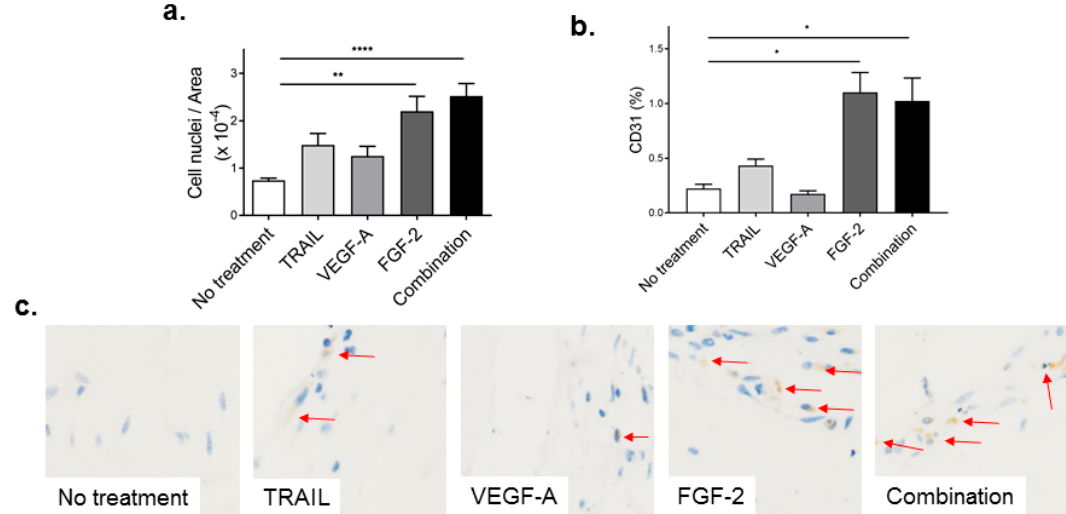
Figure 5. FGF-2 increases cell infiltration and CD31 capillaries in the Matrigel plug. Liquid Matrigel containing TRAIL, VEGF-A or FGF-2 at 400 ng/mL, or a combination of all three at 400 ng/mL each, was injected subcutaneously into the flank of C57Bl/6J mice where it solidified and formed a plug. After 14 days, plugs were excised, fixed, sectioned and assessed. ( a ) Quantification of cell infiltration into the Matrigel plug assessed from H&E sections; and ( b ) quantification of EC content by CD31 immunochemistry; ( c ) representative images of CD31 immunostaining (red arrows). All images were taken at 40 × magnification. Results are expressed as the mean ± SEM ( n = 6–7 mice per condition); ANOVA; * p < 0.05, ** p < 0.01, **** p < 0.0001.